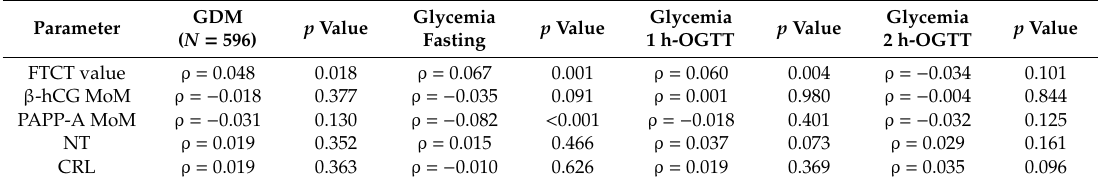
Table 2. Univariate correlations between FTCT parameters and GDM and glycemic values during oral glucose tolerance test (OGTT).